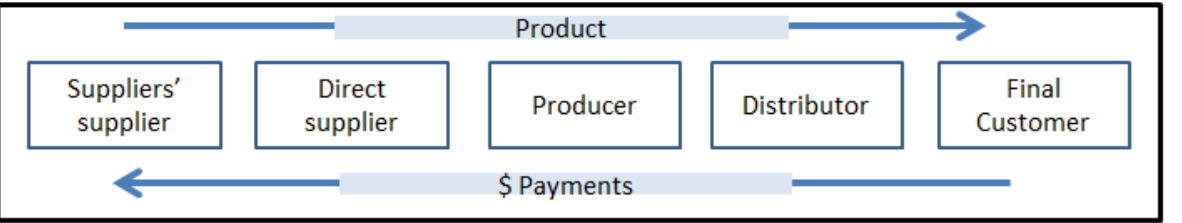
Figure 1. Simple Supply Chain